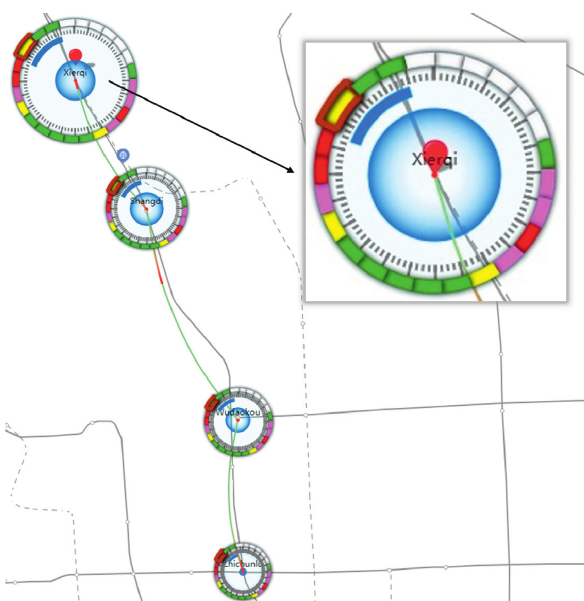
Figure 9: The diffusion view: August 13th, 2015, the anomaly spread of Xierqi